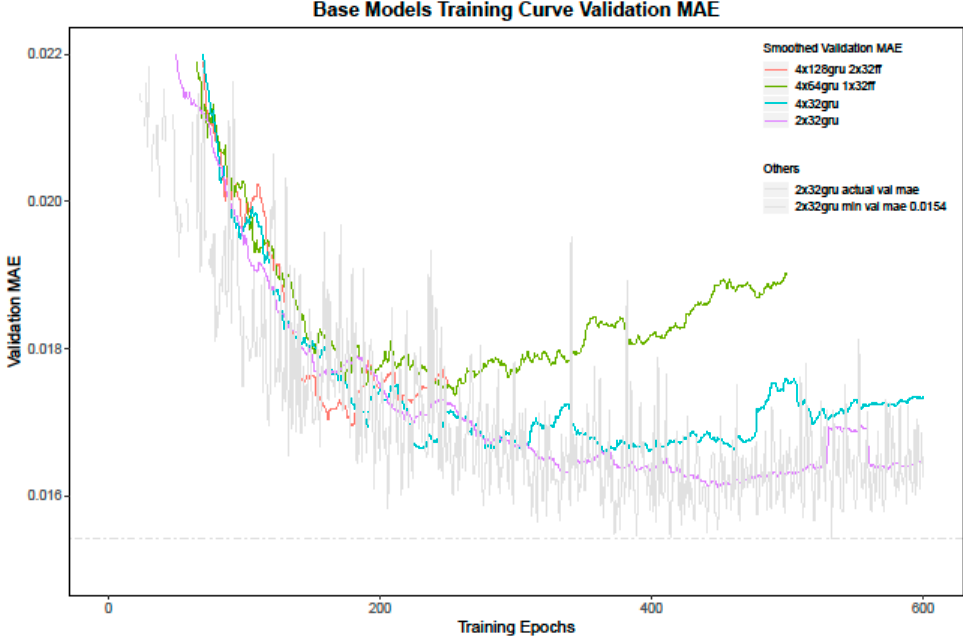
Figure 11. Base model training curves (training curves are smoothed using 20-epoch moving average; the background plot is the actual training curve of the best model).